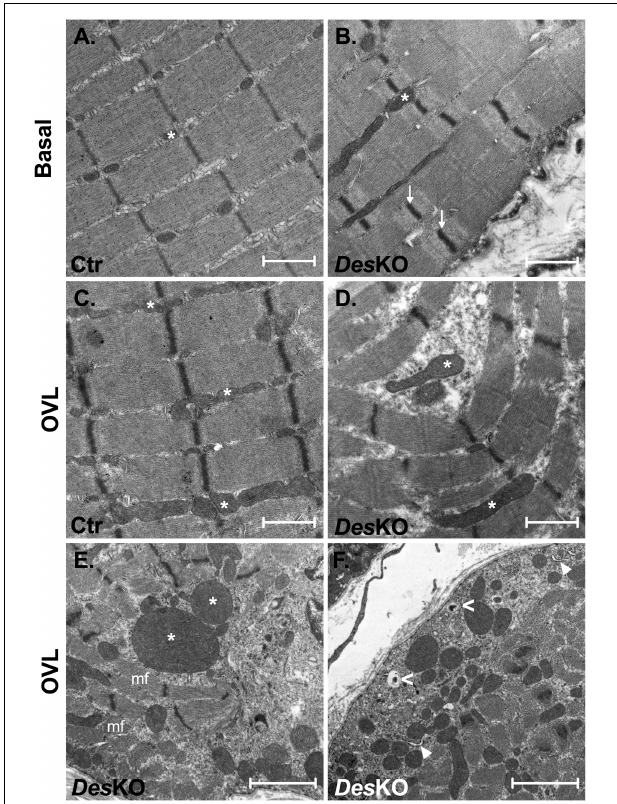
FIGURE 6 | Myofibrils organization of plantaris is highly disturbed in DesKO after OVL. Transmission electron microscopy images of ultrathin sections of plantaris of both genotype (Ctr and Des KO) in basal condition or after 1 month of OVL. Asterisks (*) indicate mitochondria; white arrows indicate Z-lines; mf indicates myofibrils; white arrowheads indicate autophagosome; white empty arrowheads indicate autolysosome. Des KO, Desmin knock-out mice; Ctr, Control mice; OVL, mechanical overloading. (A–D) Scale bar = 1 µ m. (E,F) Scale bar = 2 µ